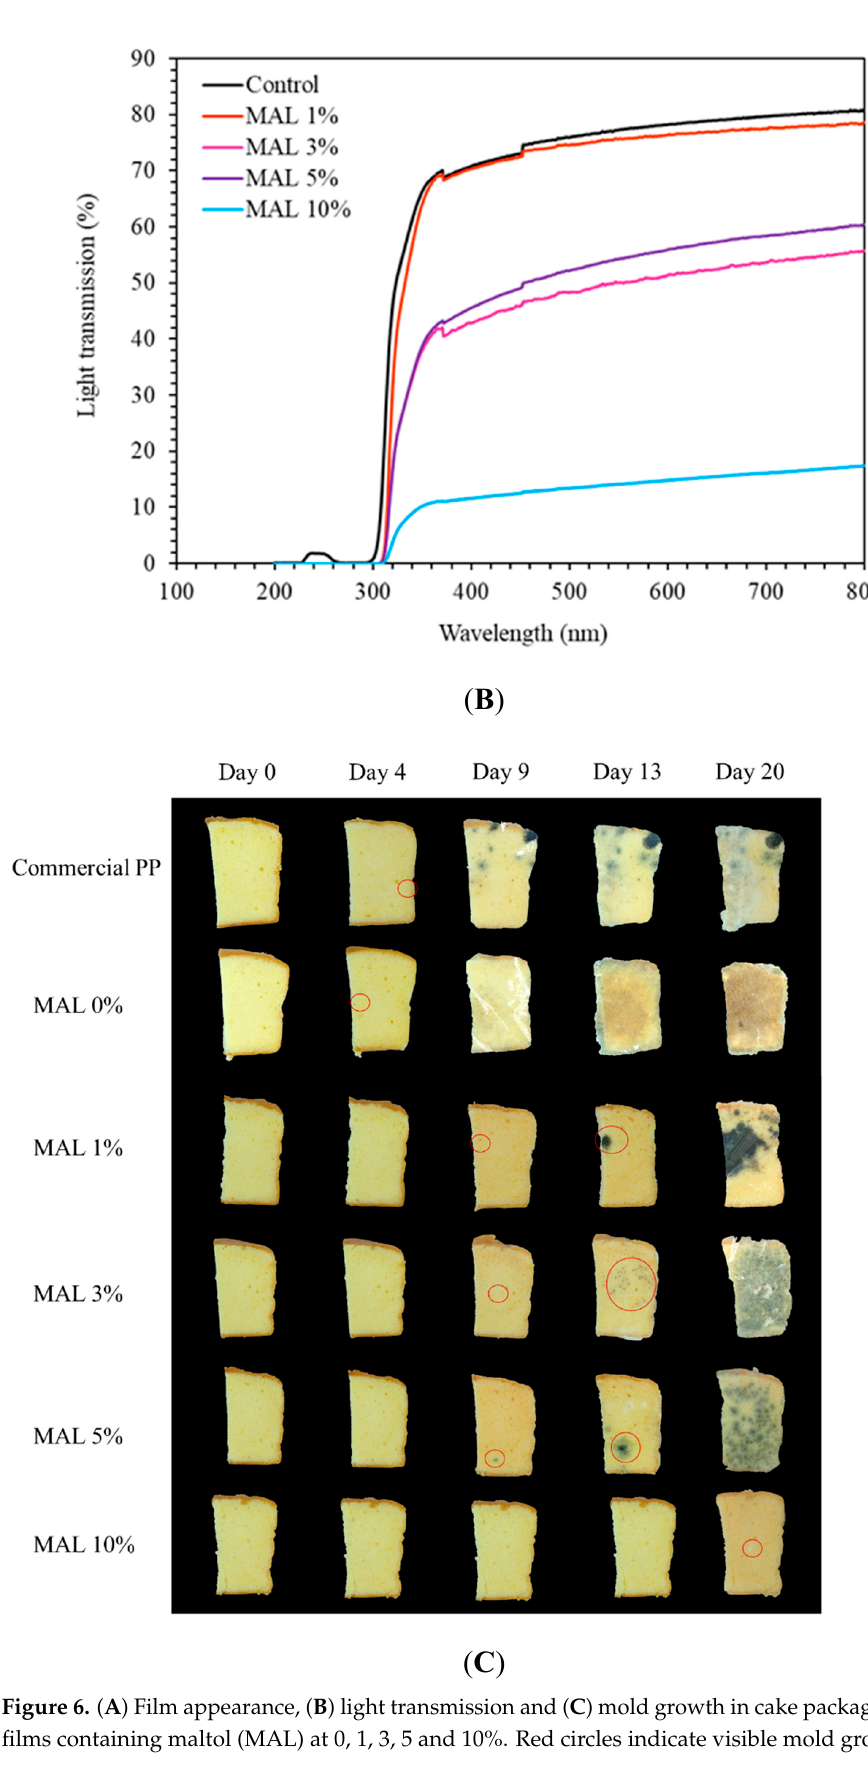
Figure 6. ( A ) Film appearance, ( B ) light transmission and ( C ) mold growth in cake packaged in starch films containing maltol (MAL) at 0, 1, 3, 5 and 10%. Red circles indicate visible mold growth.